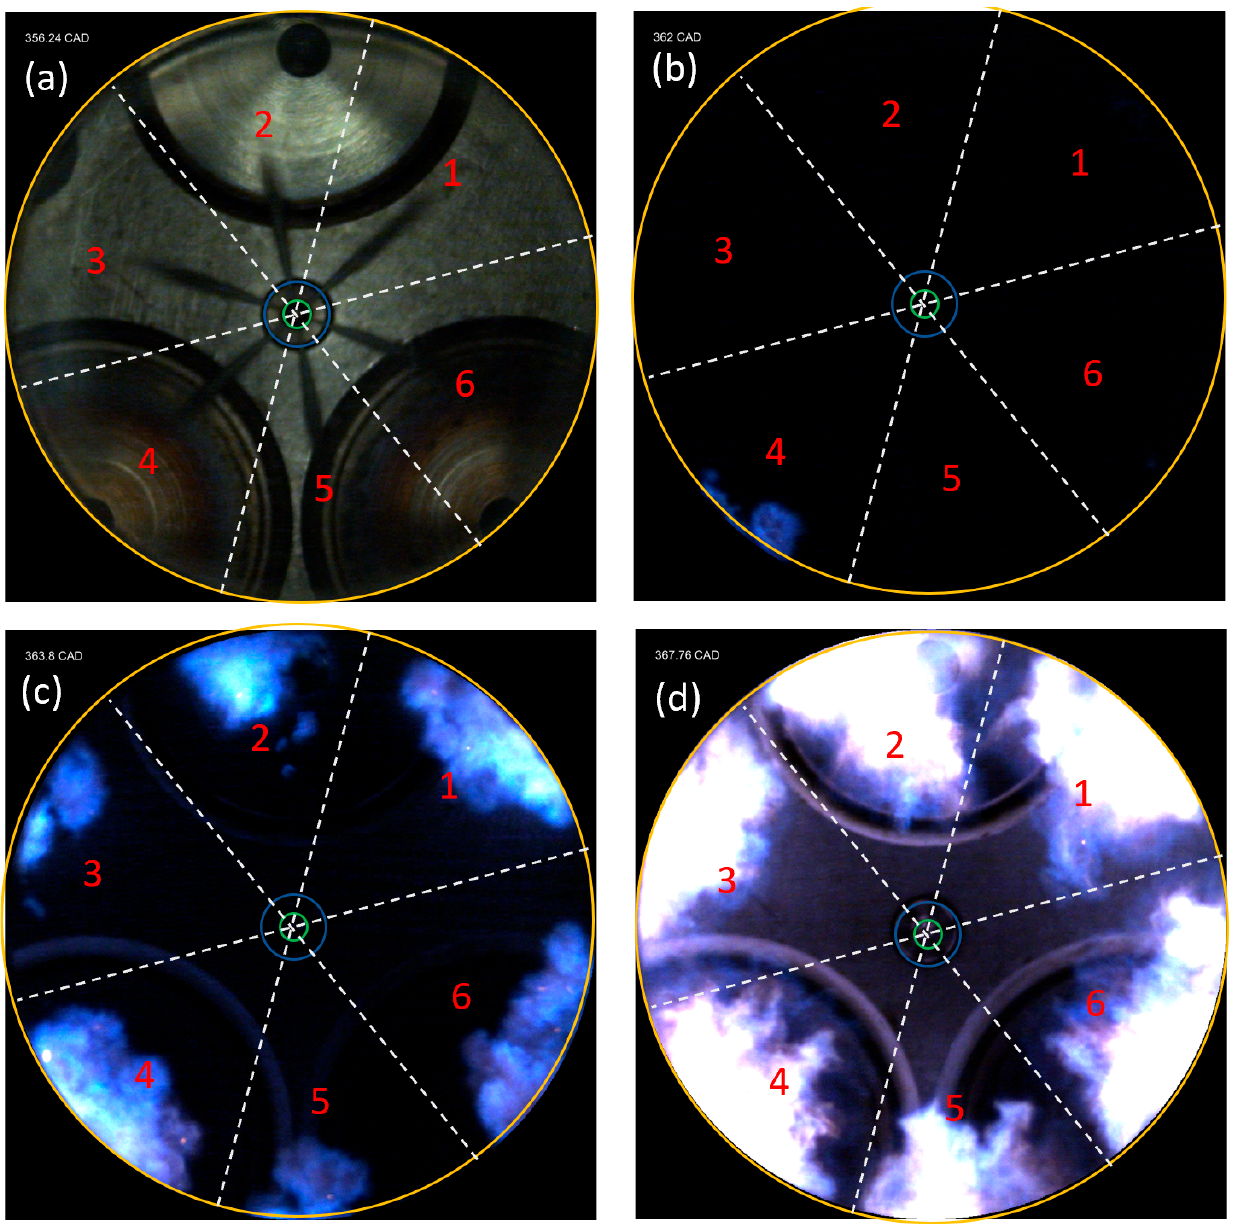
Figure 3. Raw images of the ( a ) pilot diesel spray, ( b ) flame kernel creation, ( c ) low-temperature flame propagation, and ( d ) high-temperature combustion.